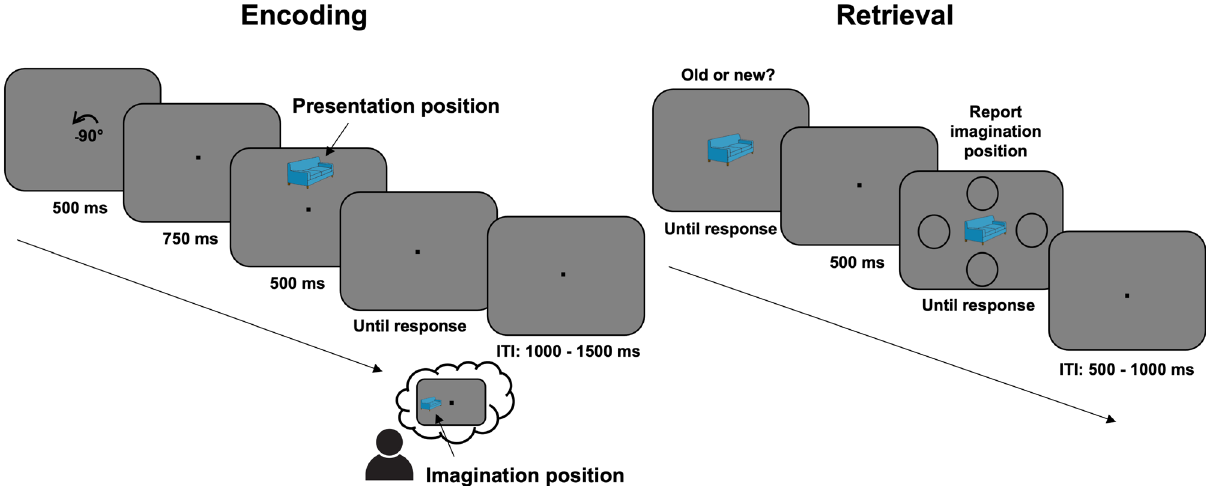
Figure 1. Schematic illustration of the experimental procedure. In the encoding phase, subjects were required to learn associations between everyday objects and imagination positions (top, bottom, left or right). Each object was presented three times during the encoding phase and was supposed to be associated with the same imagination position. In the retrieval phase, subjects completed first an old/new recognition task, in which objects from the previous phase were randomly interleaved with a set of 120 previously unseen objects. If participants reported being familiar with the respective item, they were asked to report the associated imagination position. At the end of each trial, an inter-trial interval (ITI) randomly varying between 1000 and 1500 ms (encoding phase) or 500–1000 ms (retrieval phase) was introduced.